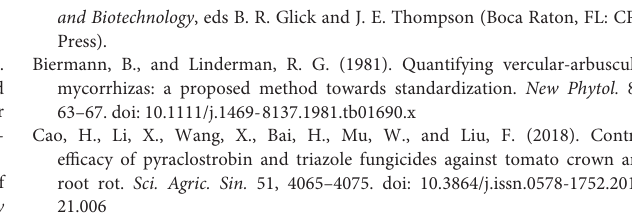
Supplementary Table 1 | The list of treatments. Supplementary Table 2 | Metabolites_full_table (NEG). Supplementary Table 3 | Metabolites_full_table